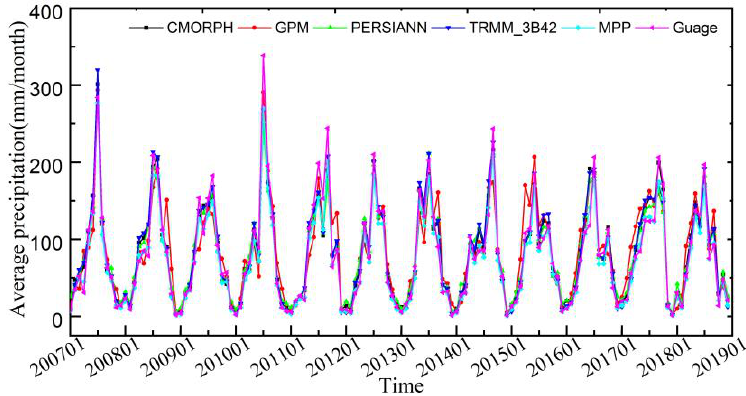
Figure 8. Time series of average monthly precipitation of gauge observation, original SPPs (TRMM_3B42, CMORPH, PERSIANN-CDR, and GPM), and MPP at the whole basin from 2007 to 2018.